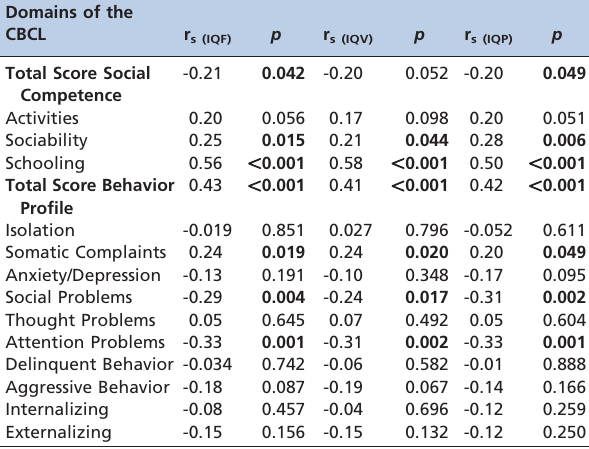
OBS: Spearman’s rank correlation coefficient (r s ); significance ( p ); IQF: full intelligence quotient; IQV: verbal intelligence quotient; IQP: performance intelligence